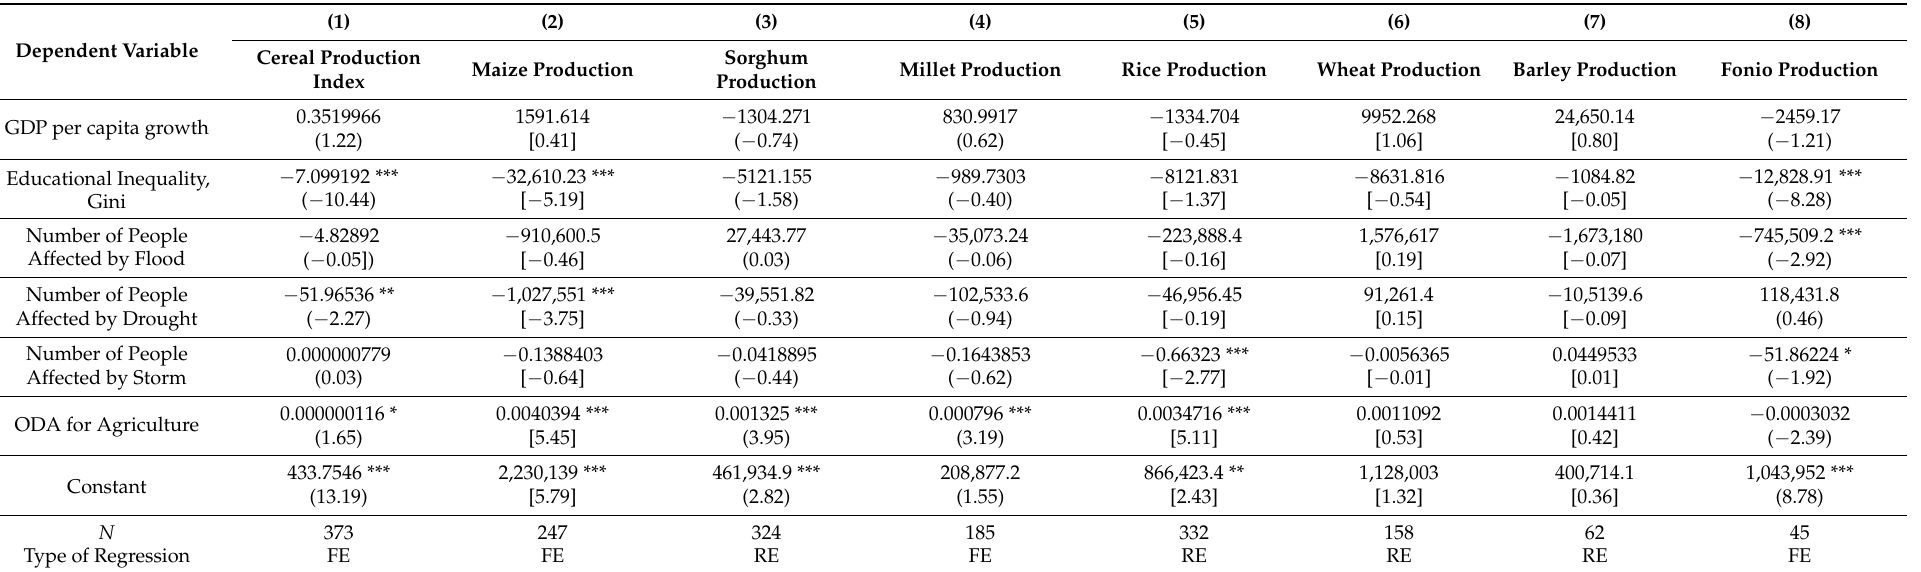
Table 5. Impact on Cereal Production by Climate-related Disasters and Aid.